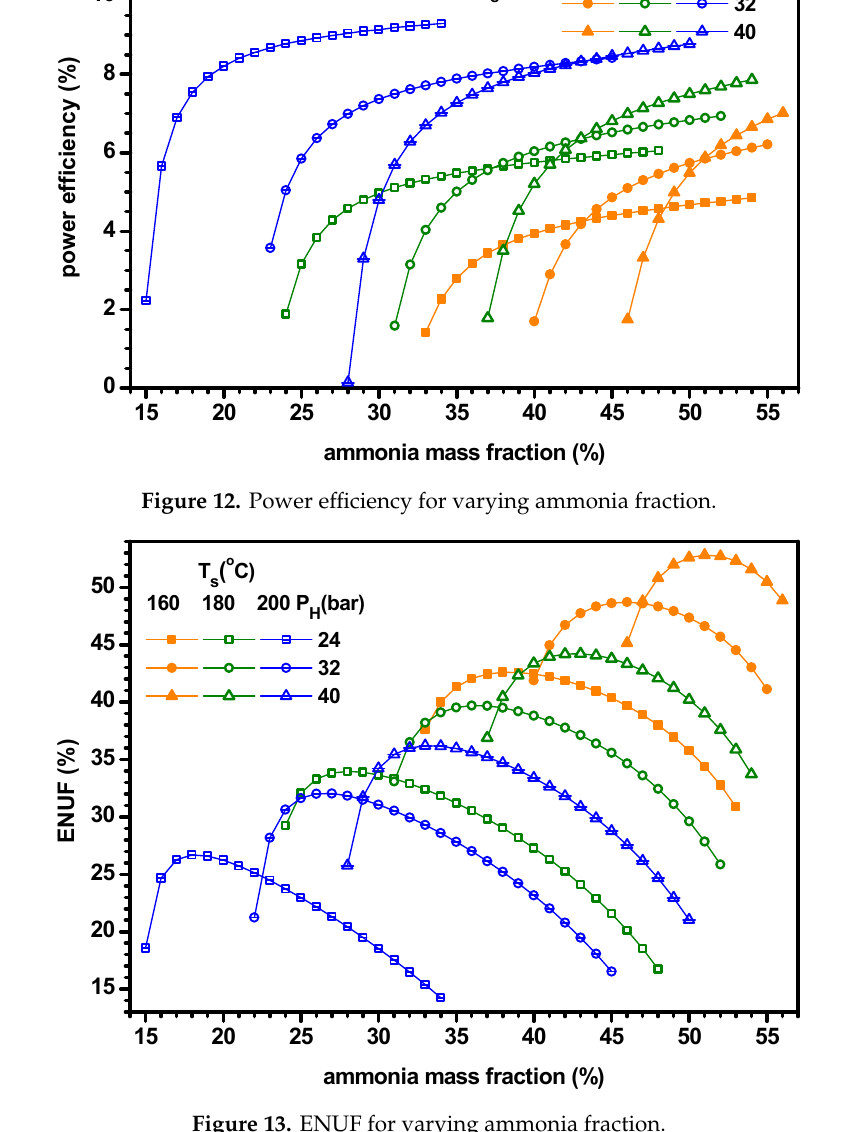
Figure 13. ENUF for varying ammonia fraction.